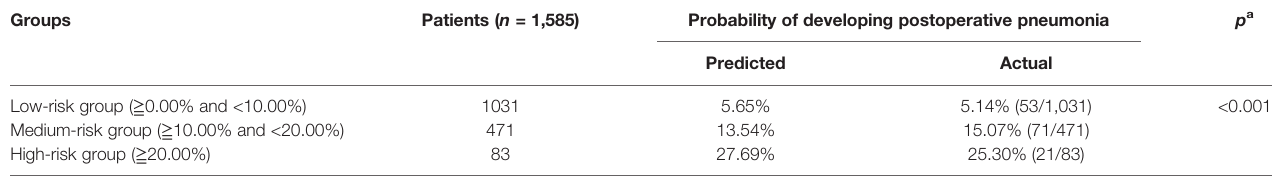
a Indicates the p-value was from the Chi-square